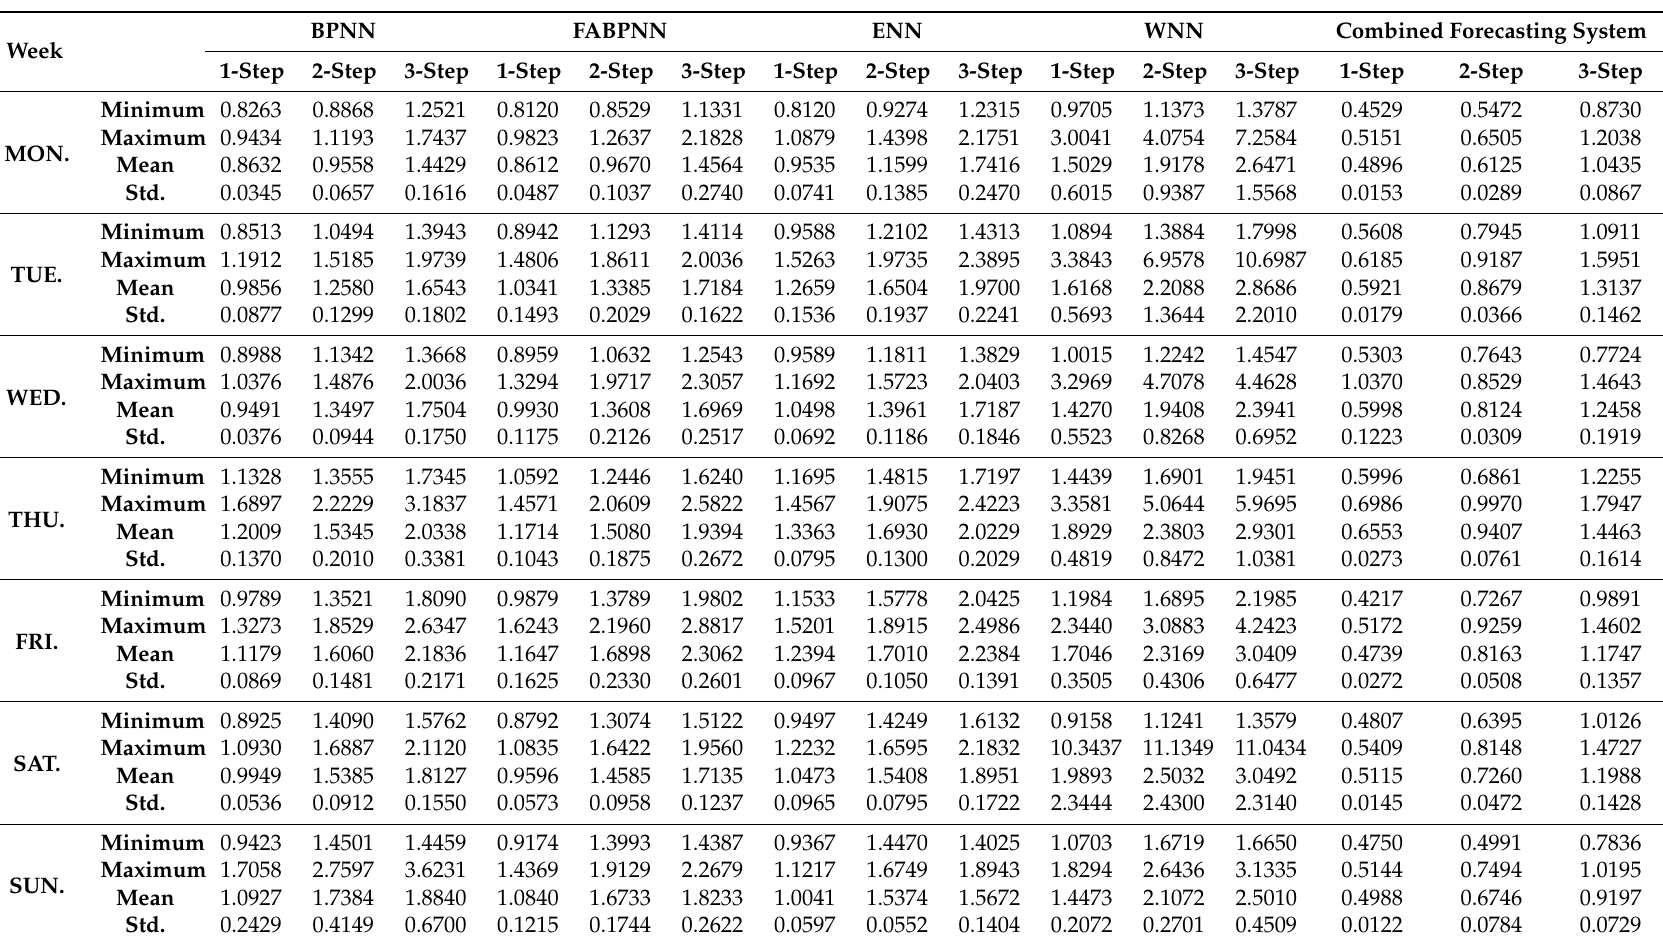
Table 6. Statistical MAPE values of February data from New South